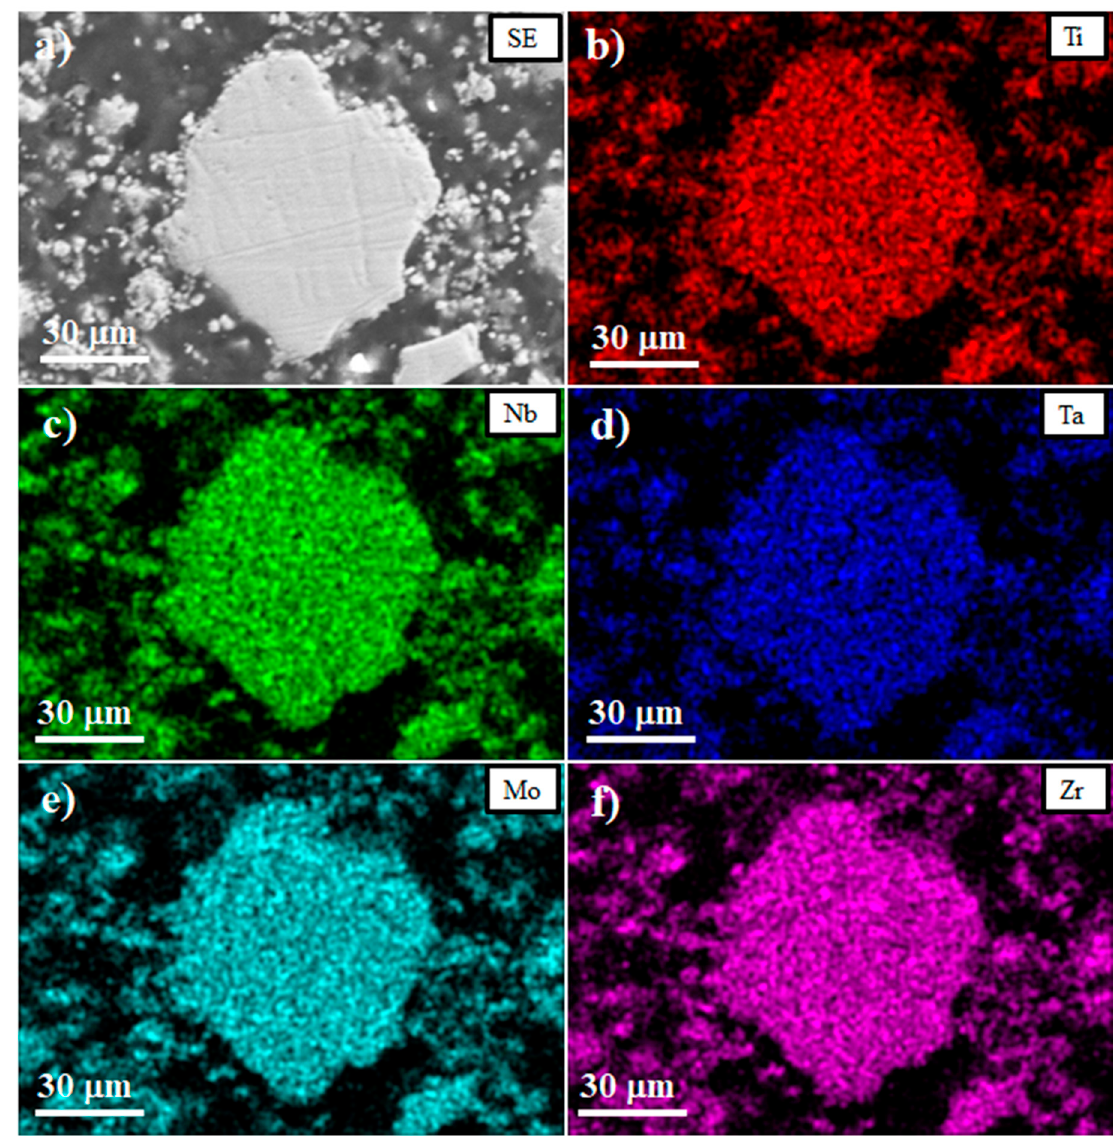
Figure 4. SEM image and EDS-mapping of the pTNTMZ10h specimen showing the distribution of the different transition metals. ( a ) Secondary electron (SE) image, ( b ) titanium, ( c ) niobium, ( d ) tantalum, ( e ) molybdenum and ( f ) zirconium.